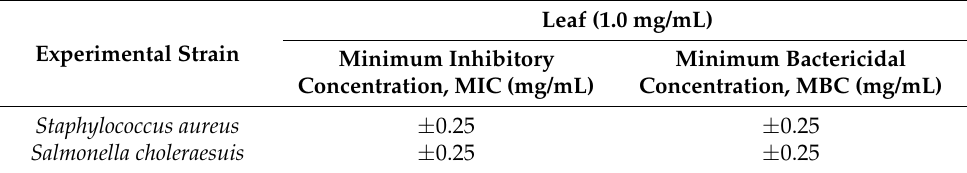
Table 5. Minimum inhibitory concentration (MIC) and minimum bactericidal concentration (MBC) values (mg/mL) of the leaf methanolic extract of Curculigo latifolia against Staphylococcus aureus ATCC 43300 and Salmonella choleraesuis ATCC